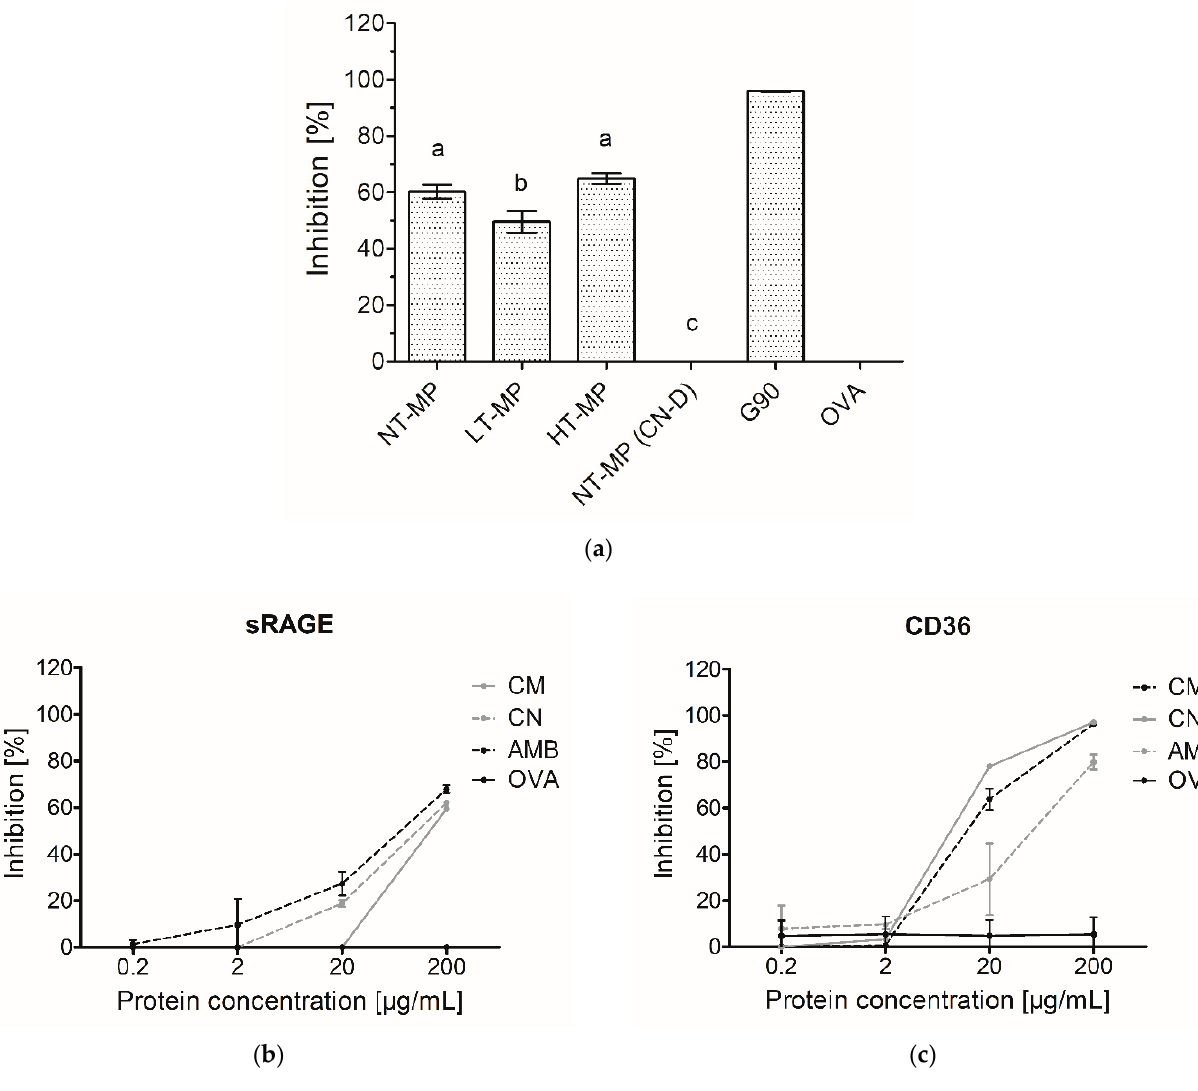
Figure 2. ( a ) sRAGE inhibition ELISA on 200 µg/mL cow’s milk protein (MP), non-treated (NT-MP), low-temperature-heated (LT-MP), high-temperature-heated (HT-MP), and NT-MP after acidic depletion of casein (CN-D). ( b ) sRAGE inhibition ELISA and ( c ) CD36 inhibition ELISA on micellar casein (CM) as well as sodium caseinate (CN) measured at different concentrations. Amyloid- β (AMB) and soy protein glycated with glucose for 90 min at 100 °C (G90) were used as positive controls, while ovalbumin (OVA) was used as a negative control. Statistical differences in ( a ) were determined using one-way ANOVA. Values were considered as statistically different at p < 0.05, with different letters indicating statistically significant differences between samples.